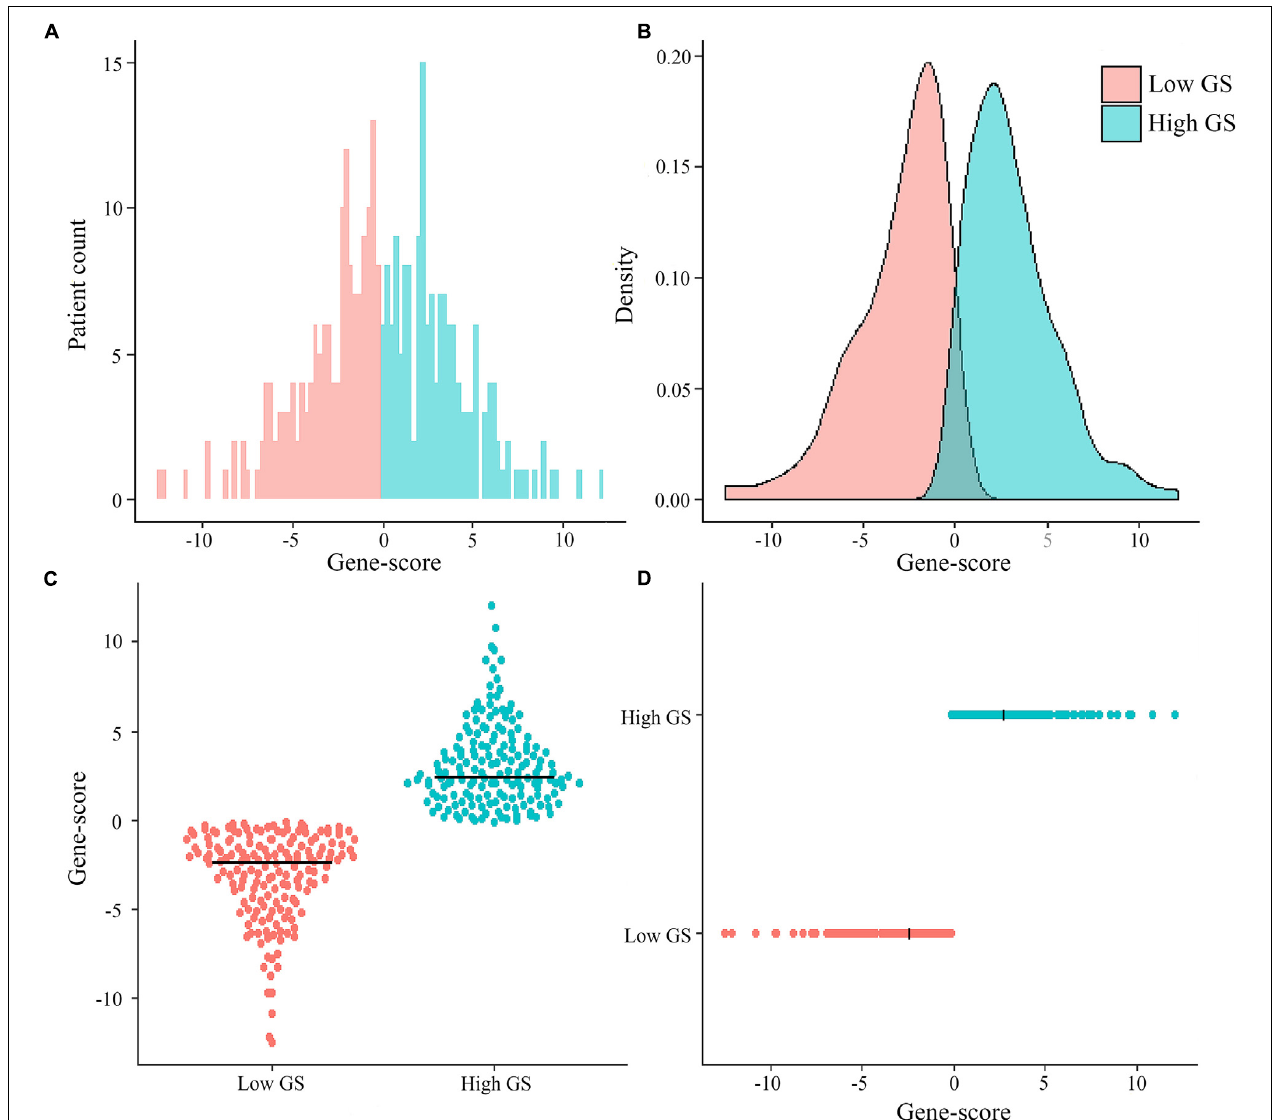
FIGURE 2 | Distribution of patient cases and density based on genomics score (GS) in the total The Cancer Genome Atlas cohort (A,B) . Scatter plots of genomics scores regarding the classification of low and high GS (C,D) , and the bold line represents the